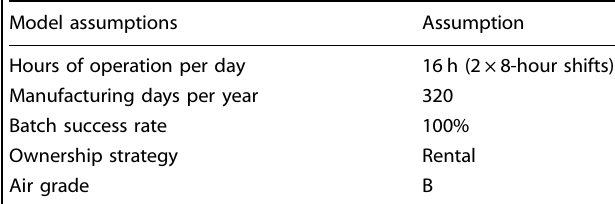
Table 1. Process assumptions. Table 2. Model